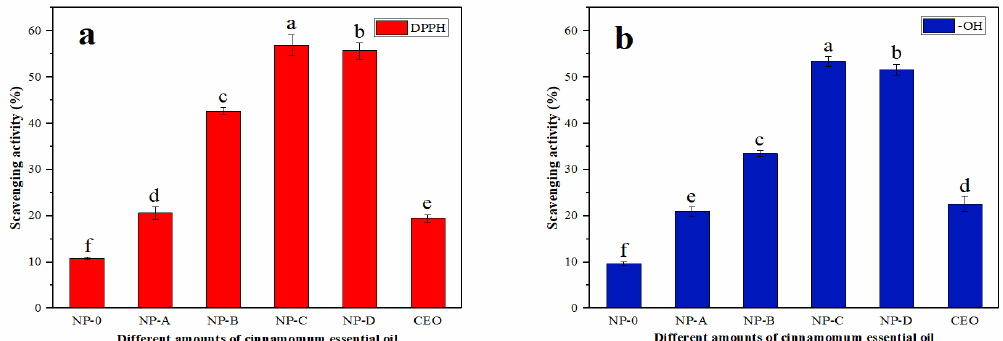
Figure 7. Scavenging activity of ( a ) DPPH and ( b ) -OH of CS-NPs loaded with di ff erent amounts of CEO (NP-0, NP-A, NP-B, NP-C, and NP-D with initial CEO to CS weight ratios of 0:1, 0.11:1, 0.25:1, 0.39:1, and 0.53:1, respectively). Bars with di ff erent letters are significantly di ff erent ( p < 0.05).